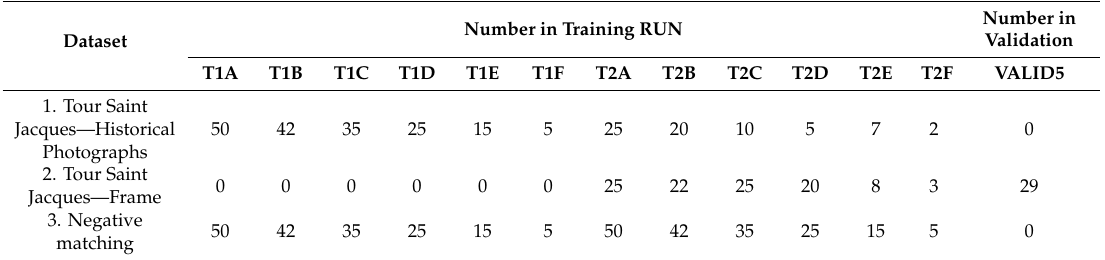
Table 4. Description of the training and validation dataset 3 on the real case of the Tour Saint Jacques. Dataset